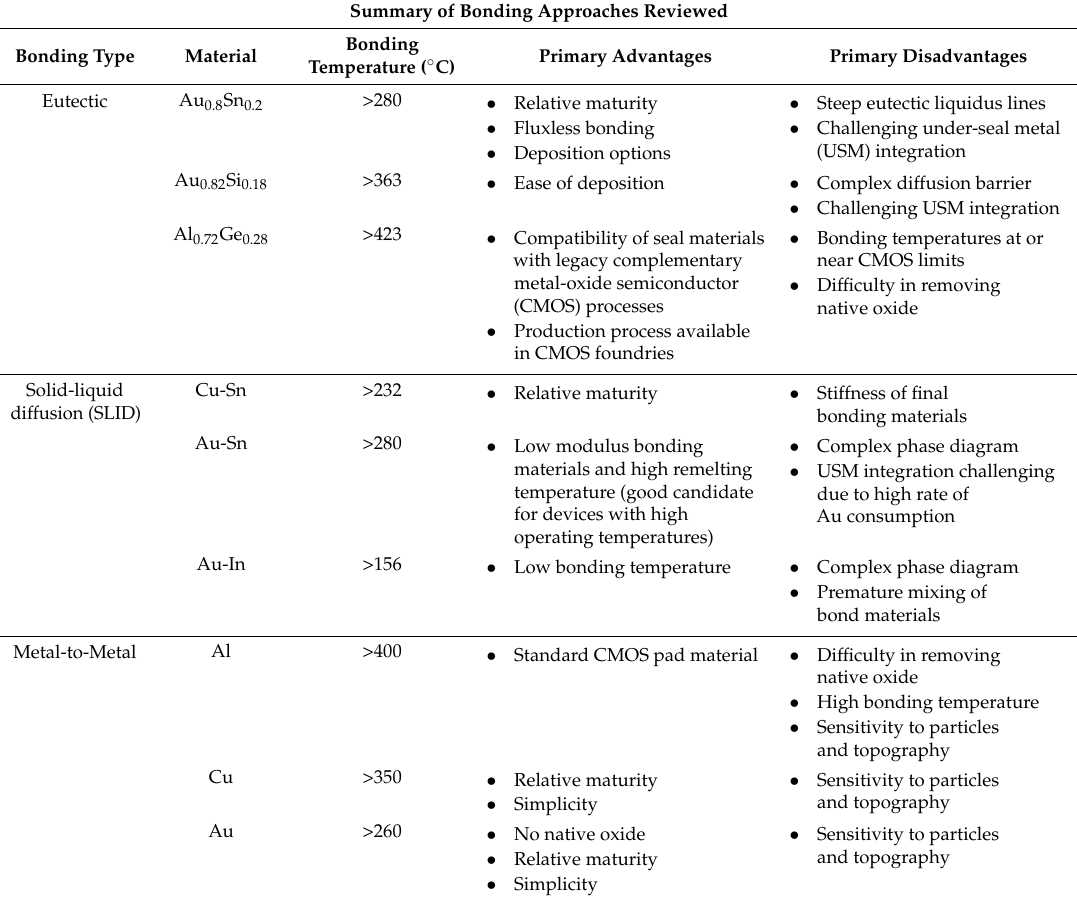
Table 8. Summary of the metal-based bonding solutions discussed in this